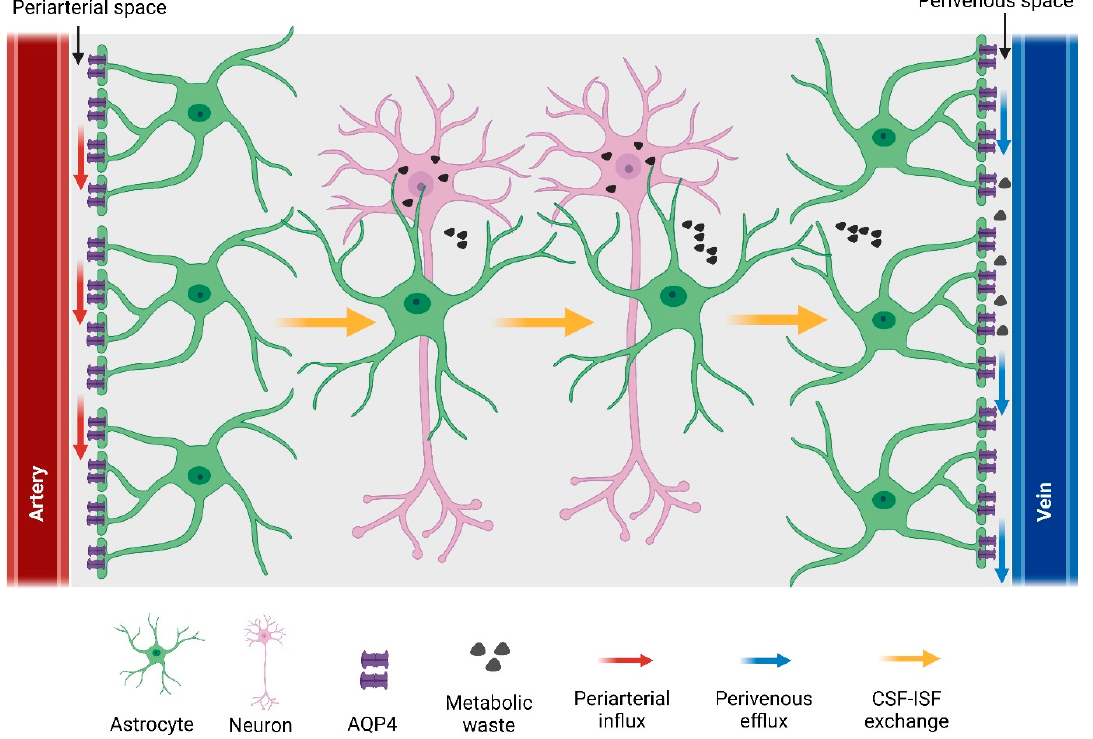
Figure 3. CNS glymphatic pathway. CSF enters the brain parenchyma along the periarterial space, clears the waste products from the brain, and leaves the brain along the perivenous space. CSF flow into and through the brain interstitium is facilitated by astrocytic AQP4 water